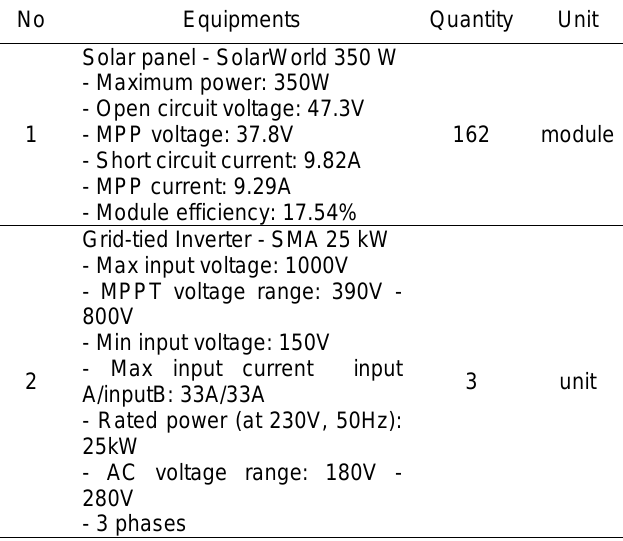
Table 2. Main equipments of the the grid-tied